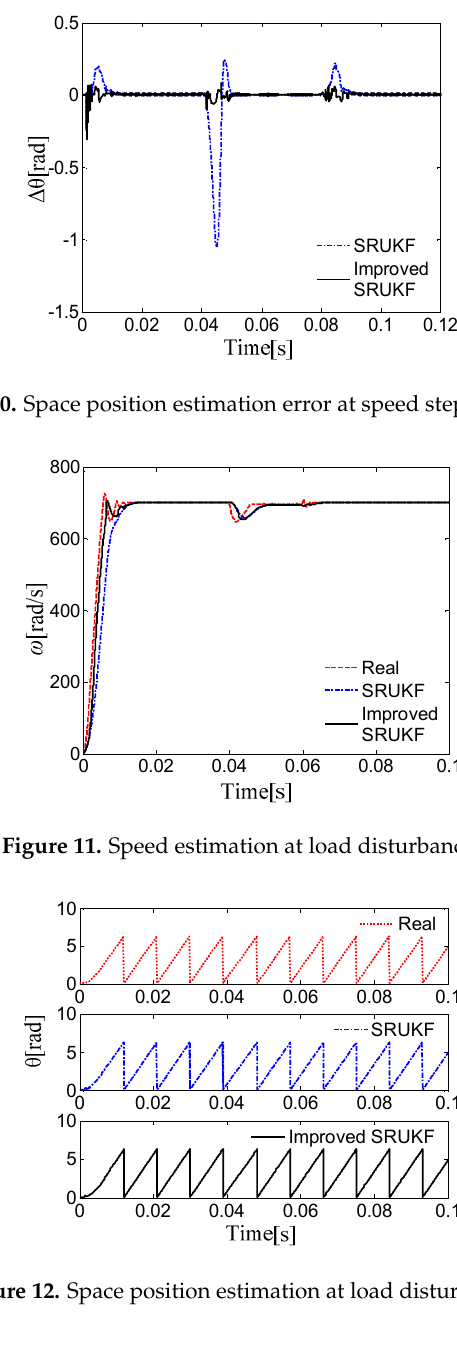
Figure 9. Space position estimation at speed step response. Energies 2016 , 9, 489